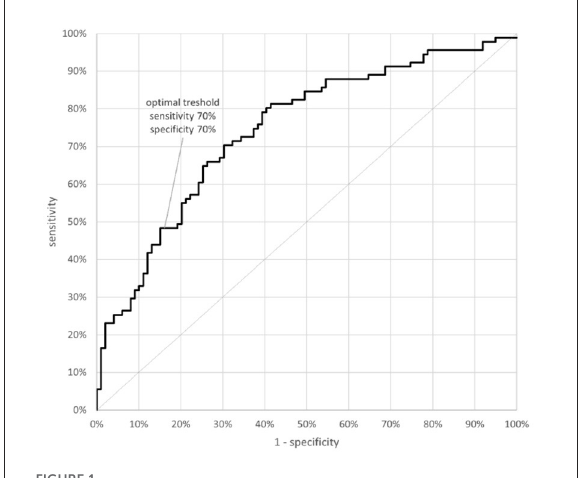
FIGURE1 ROC curve for the clinical composite asymmetry predicting probability of hospitalization due to